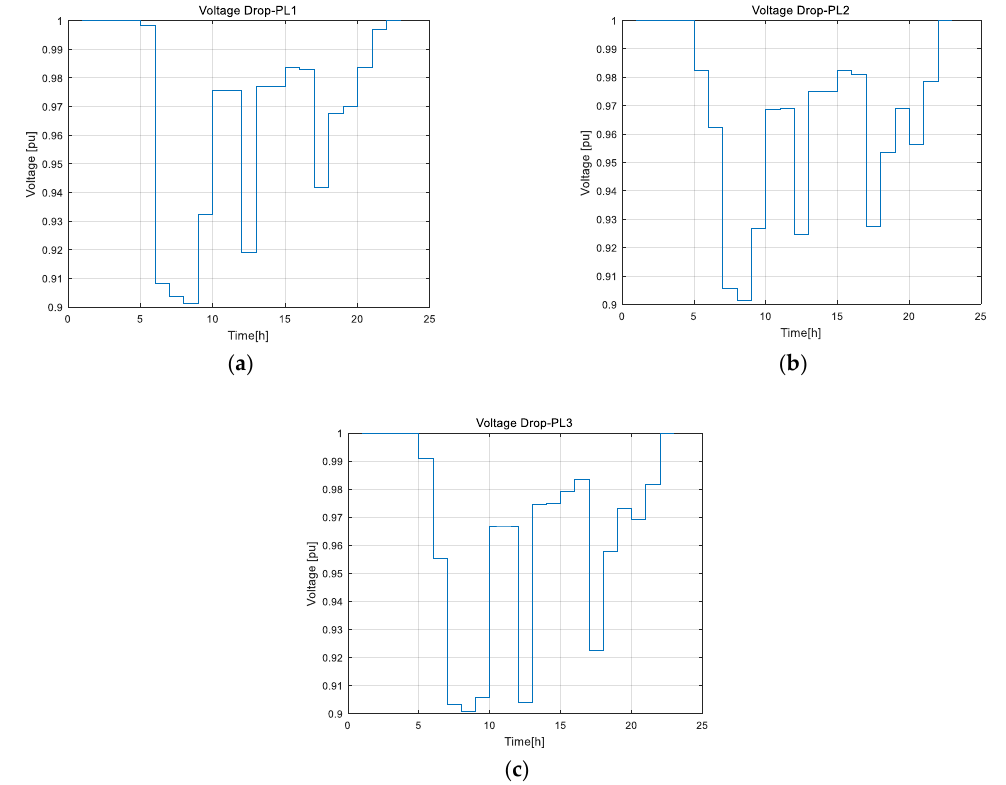
Figure 14. Parking Lot Voltage Drop with MPC ( a ) PL1, ( b ) PL2, ( c ) PL3.